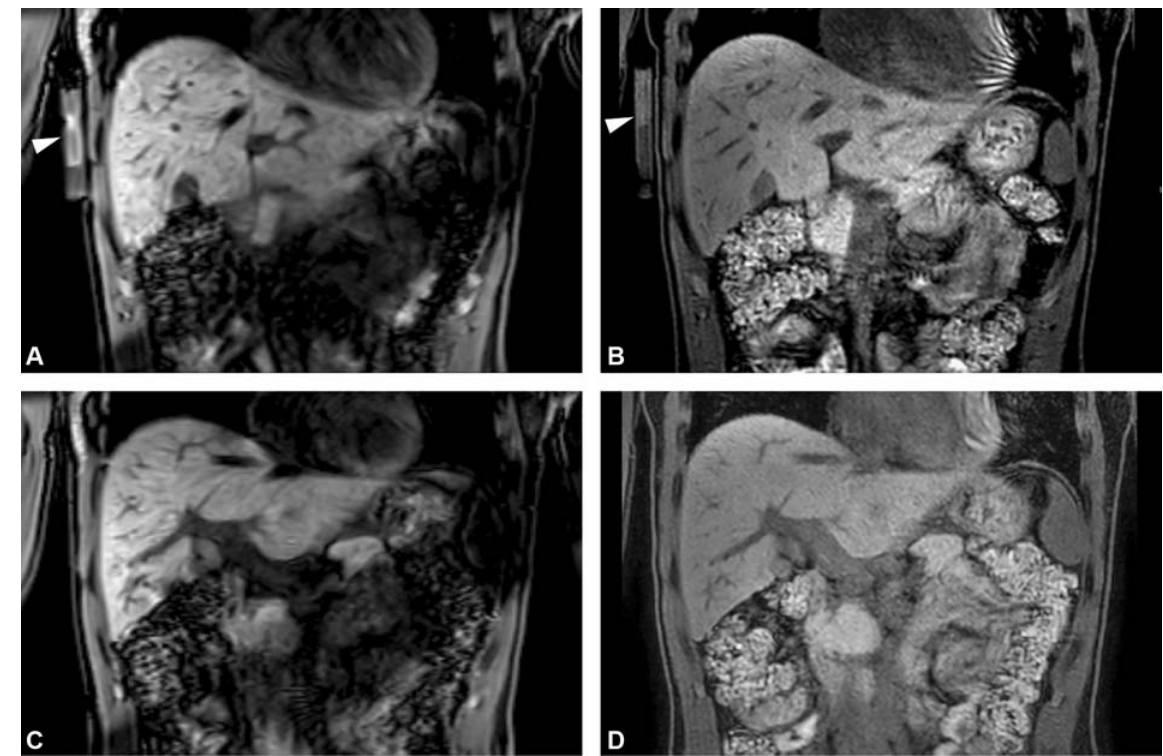
abdomen. ( A, C ) 3D T1 TFE (three-dimensional T1 turbo fi eld echo) images at two levels showing a low signal intensity in intrahepatic veins